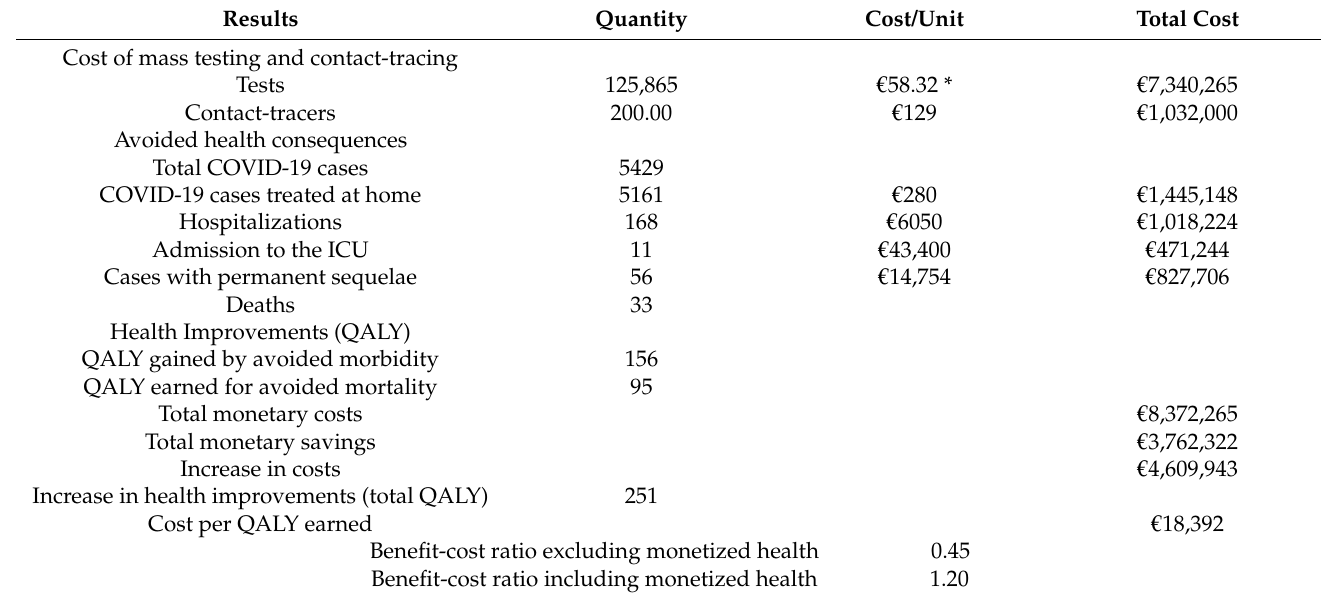
Table 3. Economic and health consequences of the TTQ strategy in Catalonia.